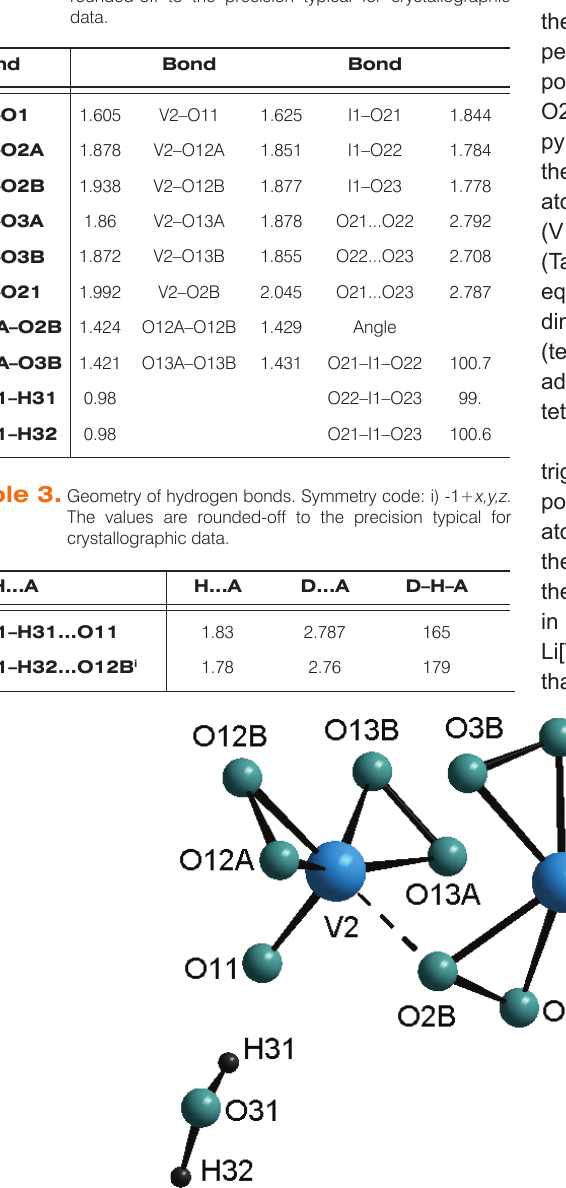
O (O ) (IO )] 3– anion and water molecule. Dashed bonds indicate weak interactions, hydrogen bonds 2 2 2 4 3